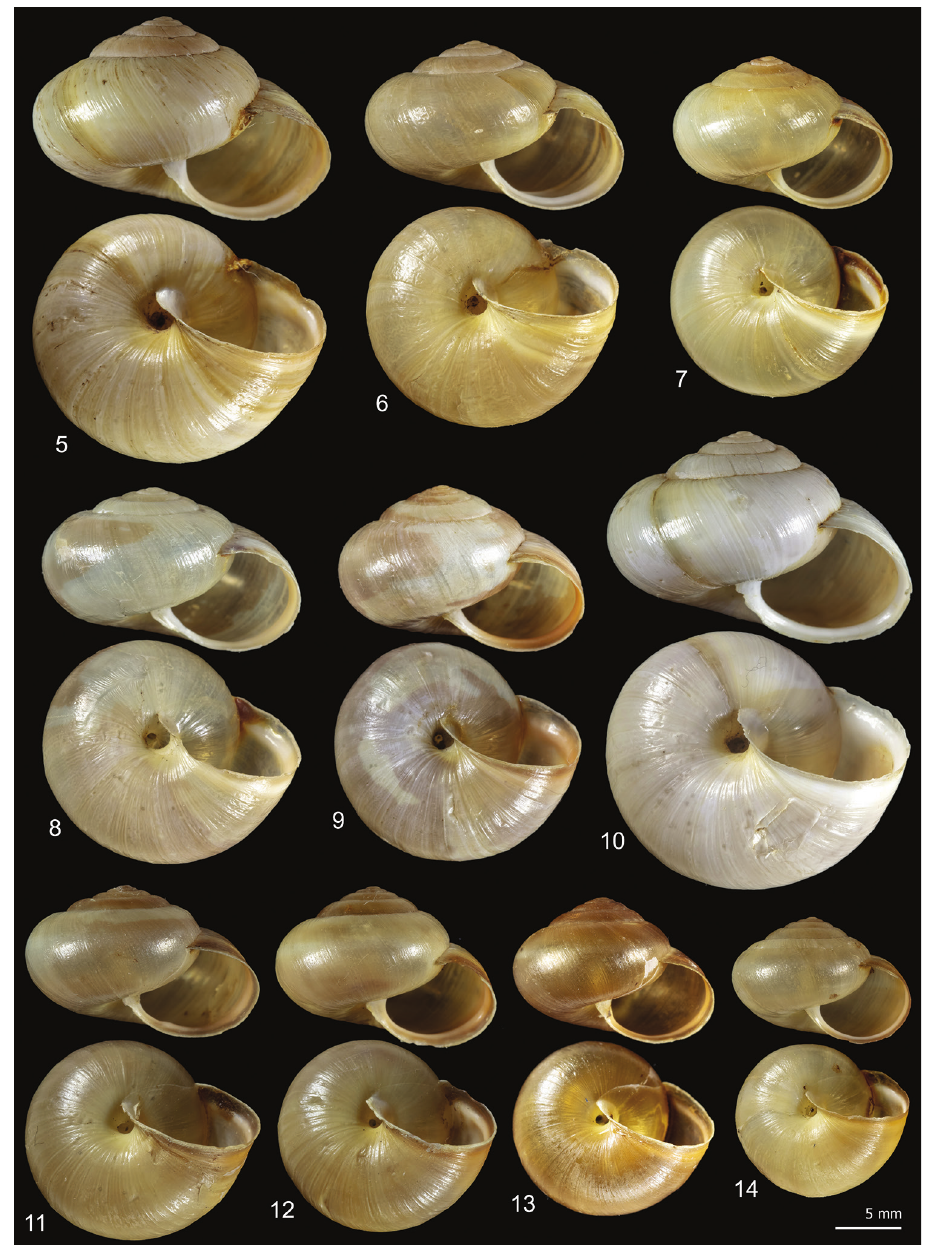
Figures 5–14. Shell variability in Monacha pantanellii from Monte Fionchi, summit [Fio1] (FGC 8140) ( 5, 6 ), Monte Fionchi, Torrecola [Fio2] (FGC 38944) ( 7 ), road to Montenero Sabino [Sab] (FGC 41552) ( 8–10 ) and Turania [Tur1] (FGC 42971) ( 11–14